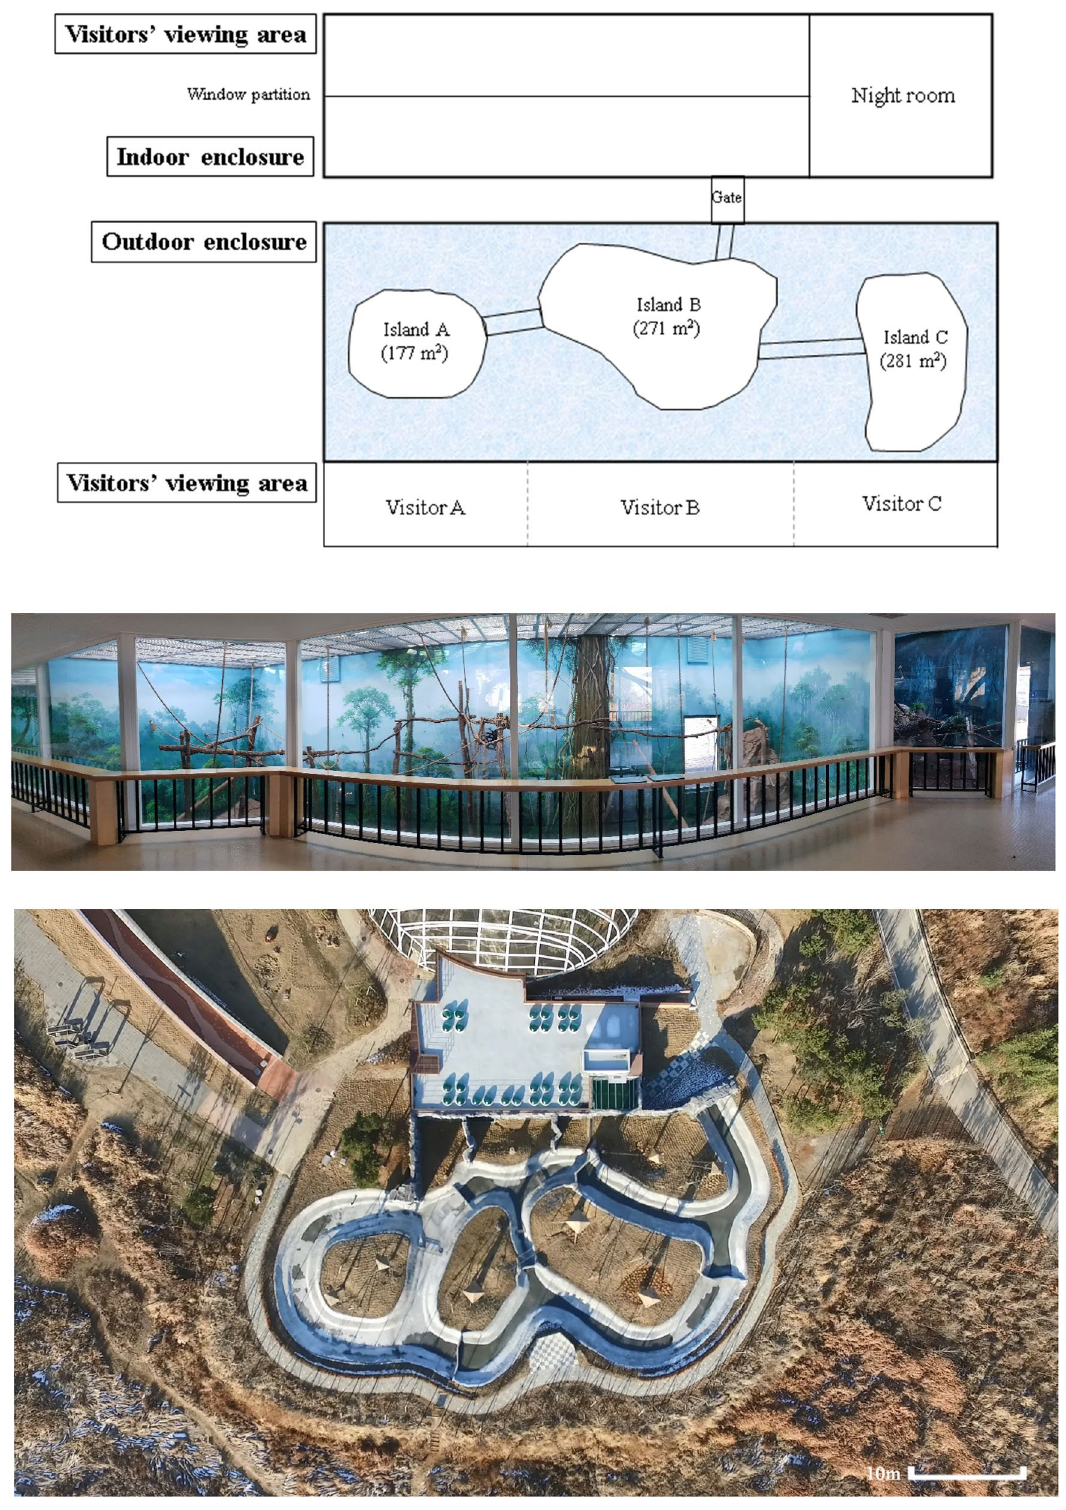
Figure 1. (Top) Aerial-view drawing of indoor and outdoor enclosures and the visitors’ viewing area. (Middle) Panoramic view of the indoor enclosure. (Bottom) Aerial view of the outdoor